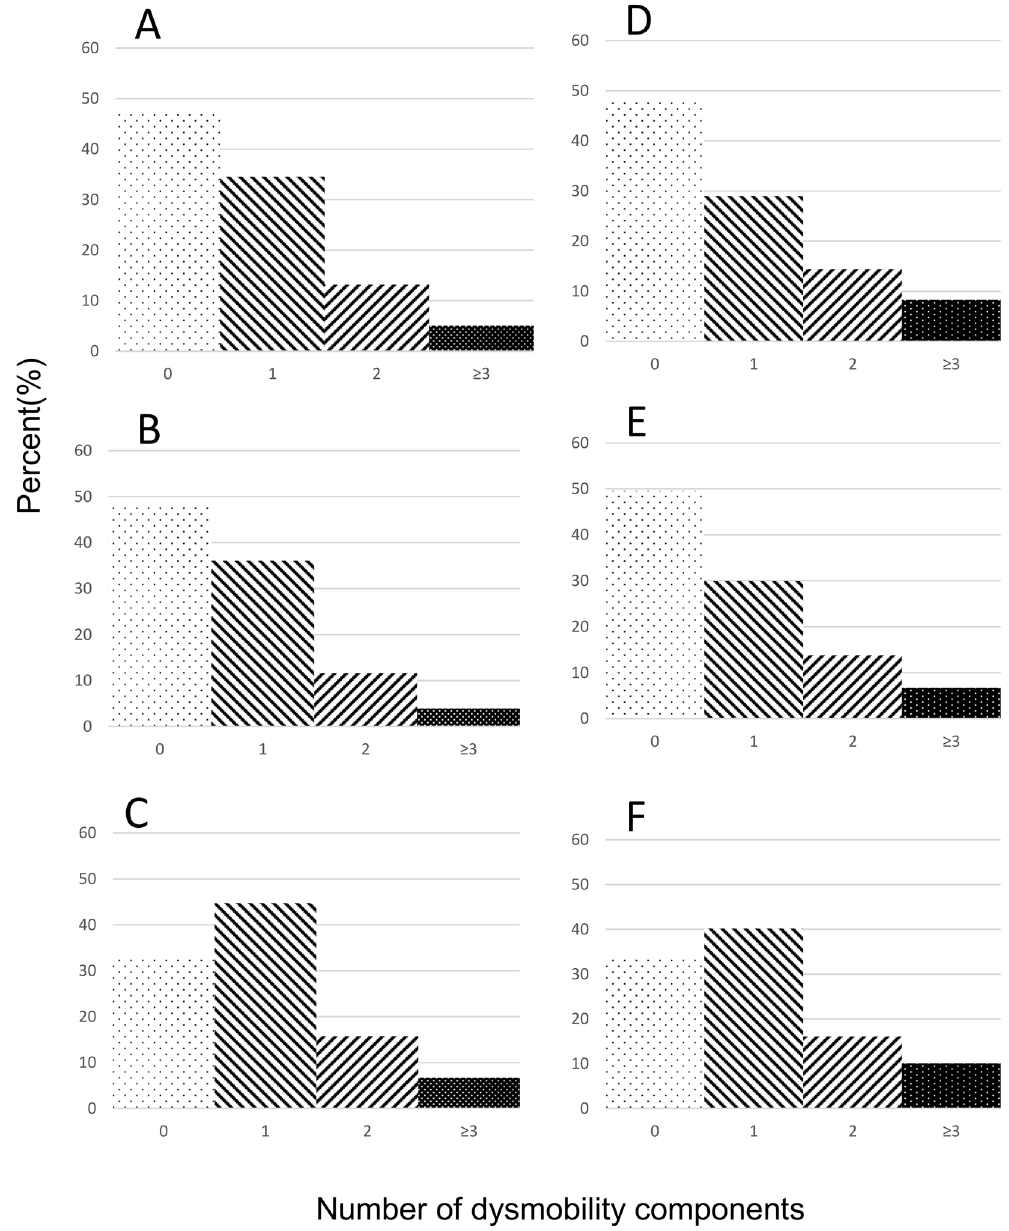
Figure 1. Distribution of dysmobility components by various muscle and fat definitions. Distribution of dysmobility syndrome by ( A ) original definition; ( B ) obesity determined by body mass index ( C ) obesity determined by central obesity ( D ) BMI adjusted muscle index ( E ) BMI adjusted muscle index plus obesity determined by BMI ( F ) BMI adjusted muscle index plus obesity determined by central